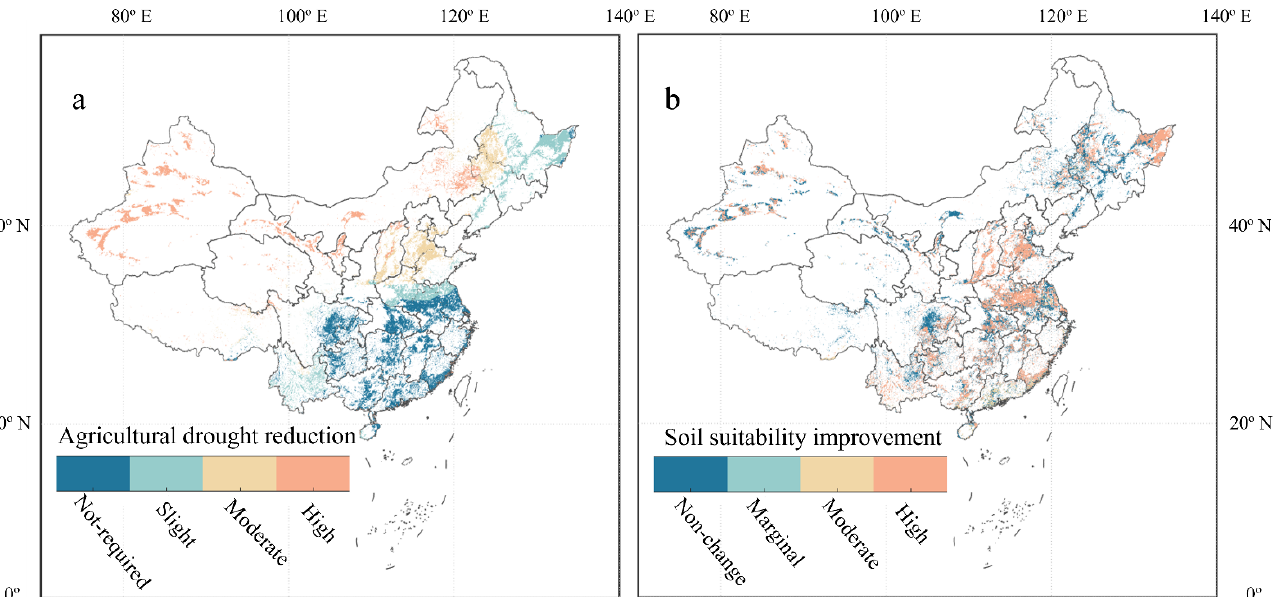
19 of 29 Figure 9. Spatial distributions of land-use transitions caused by irrigated cropland changes during 2000 – 2019: land-use transitions led by irrigated cropland abandonment ( a – g ) and expansion ( b – h ) in 5-year periods. Here, we took rainfed cropping systems with low-level inputs and traditional man- agement as references and investigated irrigation expansions with high-level inputs and advanced management that led to potential positive changes in terms of agricultural drought reduction and soil suitability improvement, as described in Figure 10. Under un- even precipitation distribution, there was a significant spatial difference in the effect of irrigation on water deficit alleviation, a gradual decrease from northwest to southeast, as show in Figure 10a [27]. The north benefited more from massive irrigation expansions induced by yield constraints that overcame rainfall shortages during cultivation. Hot zones of irrigation expansion in HHHP and NEP were, respectively, in the south and east, which are considerably low water-stress areas at the local level (Figures 9b – h and 10a). It suggested that the irrigation expansion in the north, except NIR, avoided hot spots of wa- ter shortage and made a trade-off between water security and food security. During the irrigation expansion process, soil suitability could be widely upgraded into high suitabil- ity by improving input and management, especially in key grain-producing areas, such